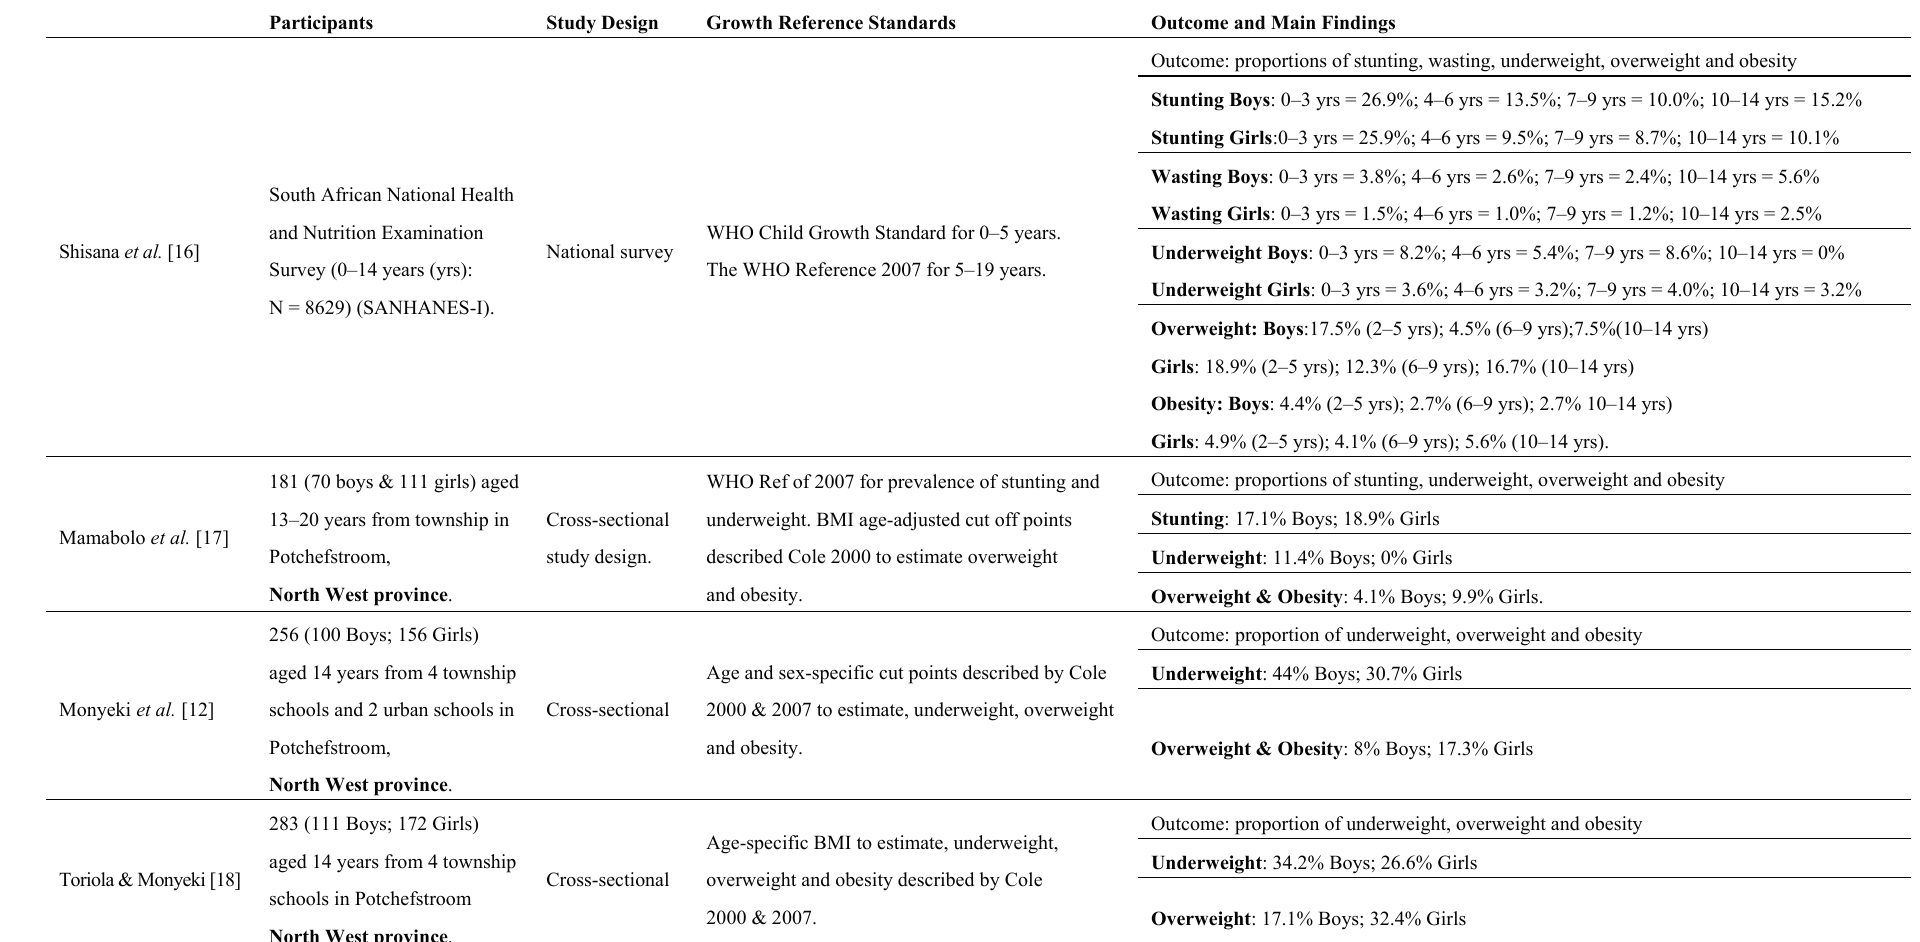
Table 1. The 19 selected studies with prevalence of malnutrition as measured by underweight, stunting, wasting, overweight and